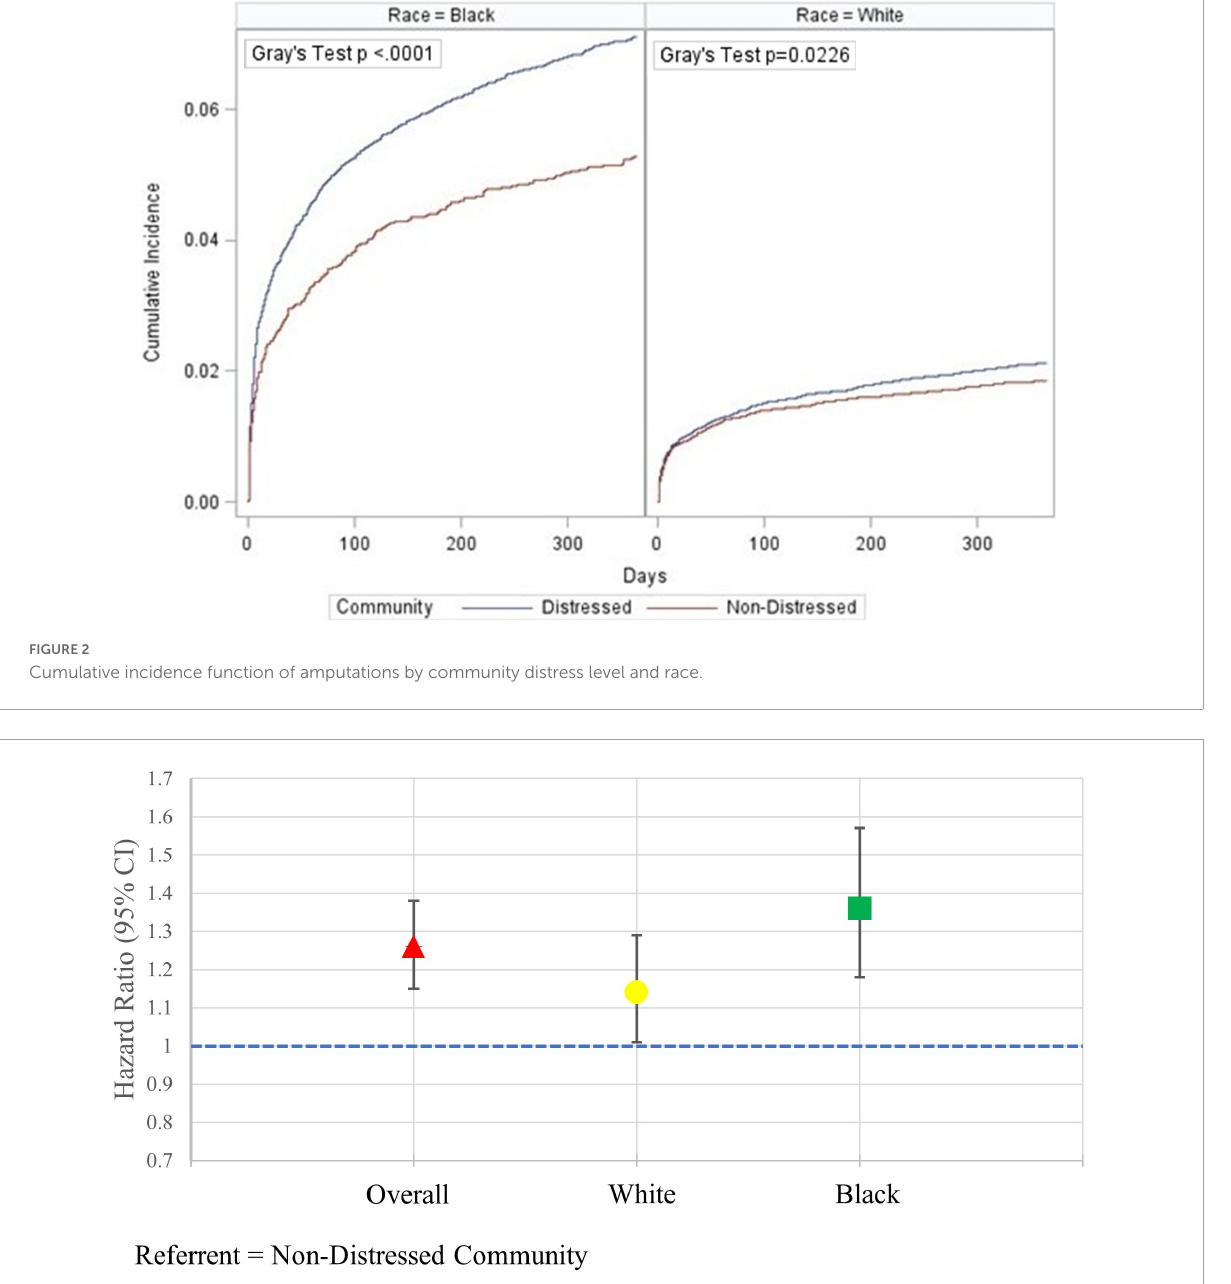
FIGURE3 Adjusted hazard ratios of major amputation in the overall population and stratified by race.